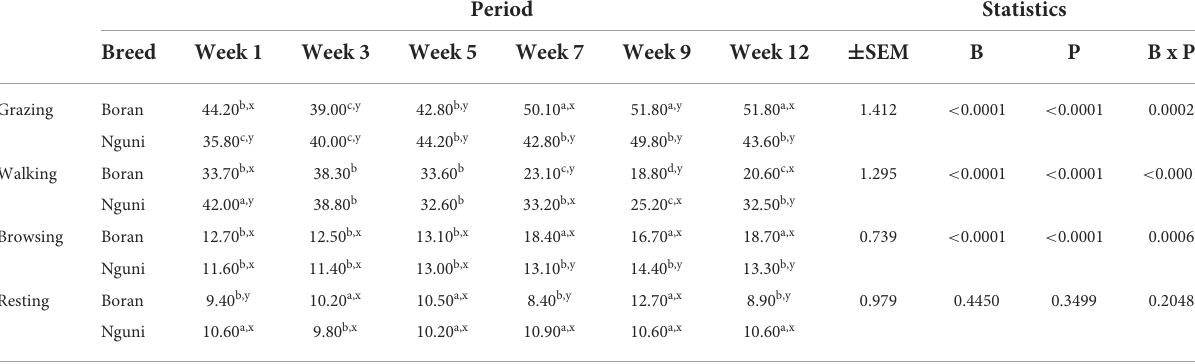
TABLE 2 LSMeans for the proportion of time spent on different behavioral activities according to breed and observation period. Period Breed Week 1 Week 3 Week 5 ± SEM B P B x P